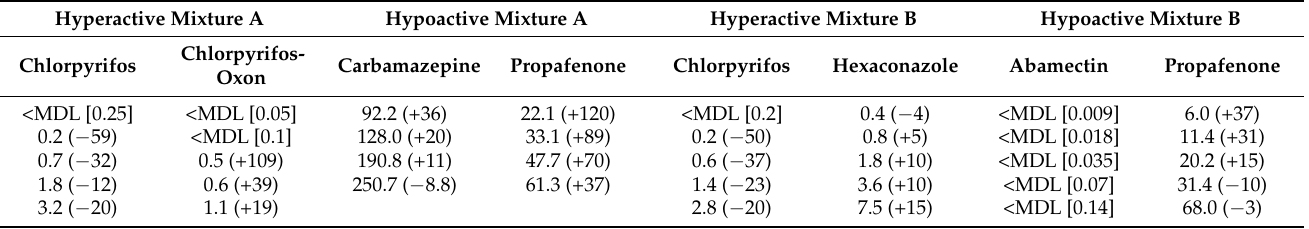
Table 3. Measured concentrations of single substances in each mixture in micromole/liter. Values in round brackets are the percentage change of the measured concentrations with respect to the nominal concentrations while values in squared brackets are nominal concentrations that are below detection